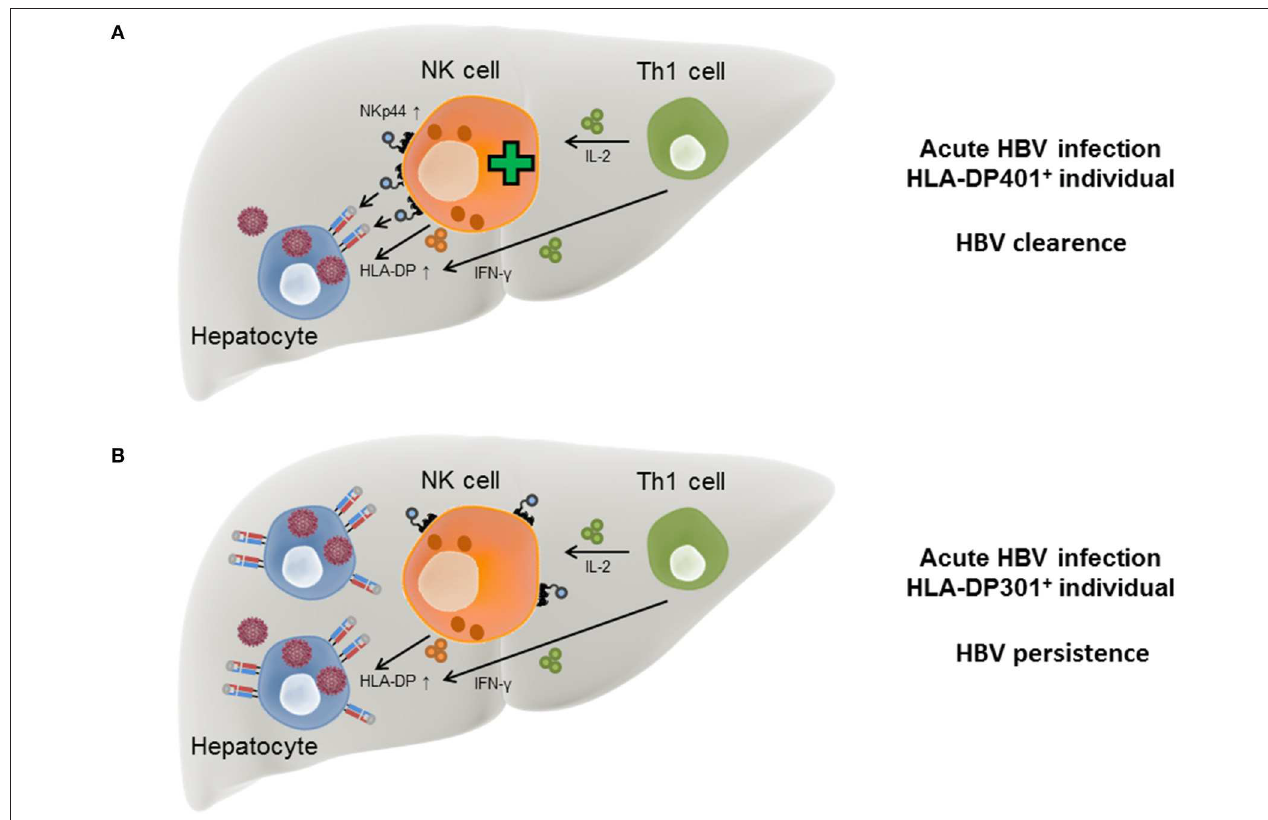
FIGURE 2 | Model for HLA-DP-NKp44 interactions during HBV infection in individuals with different HLA-DP genotypes. During acute HBV infection HLA-DP molecules are upregulated on the surface of human hepatocytes in response to IFN- γ secreted by Th1 and NK cells. NKp44 expression by NK cells is initiated by IL-2 secreted by Th1 cells. In HLA-DP401 + HBV-infected individuals, NKp44 interacts with HLA-DP401 molecules expressed on the surface of infected hepatocytes, contributing to lysis of infected cells and HBV control (A) . In HLA-DP301 + HBV-infected individuals, NKp44 is unable to bind to HLA-DP301 molecules expressed on the surface of infected hepatocytes, resulting in inefficient lysis of infected hepatocytes by innate immune cells and higher risk of chronic HBV infection (B)